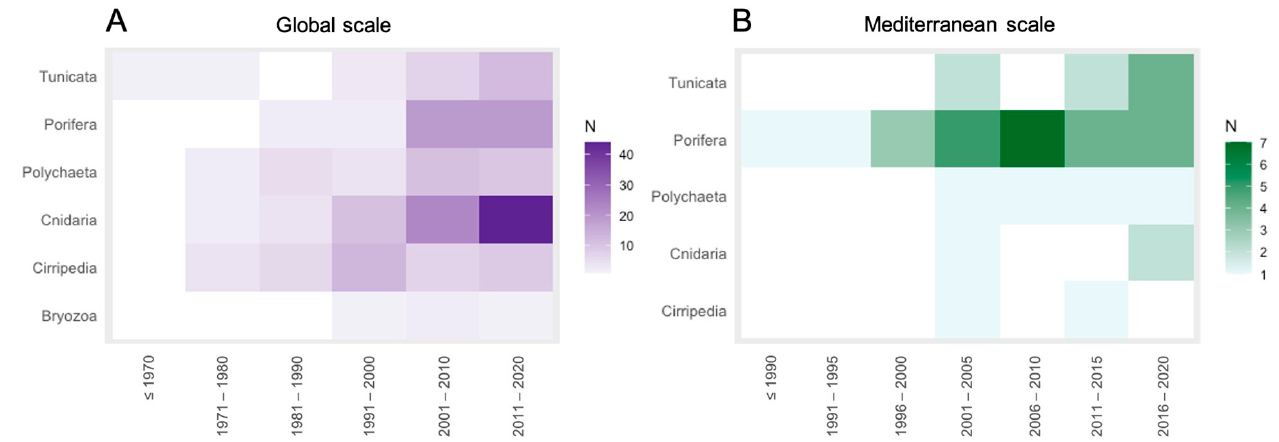
Figure 3. Number of documents per: ( A ) decade, at global ‐ scale and ( B ) 5 ‐ year period, at Mediterranean ‐ scale.